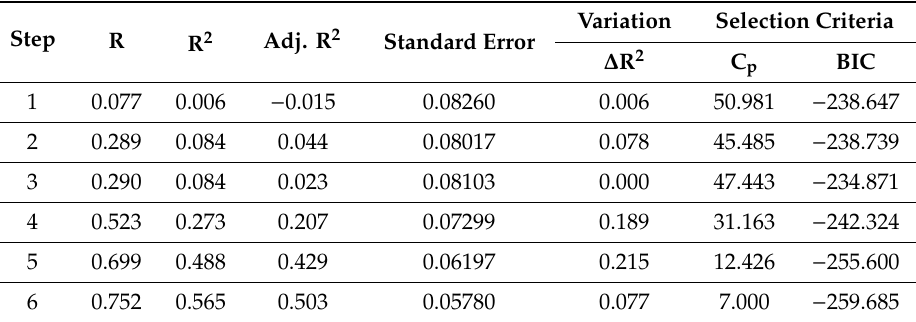
Table 5. Test regression model 2.